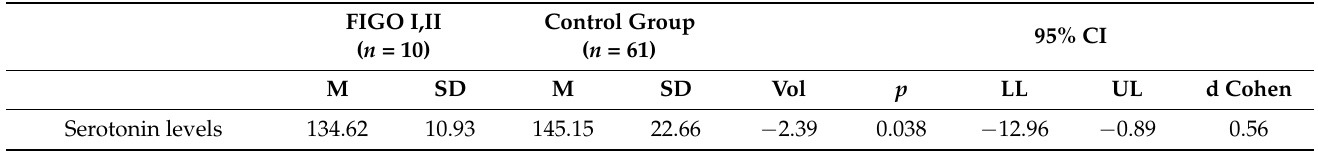
Table 5. Serotonin preoperative levels in the study group (with ovarian cancer—I–II stage according to FIGO) and the control group (with benign neoplastic lesions and simple ovarian cysts). FIGO